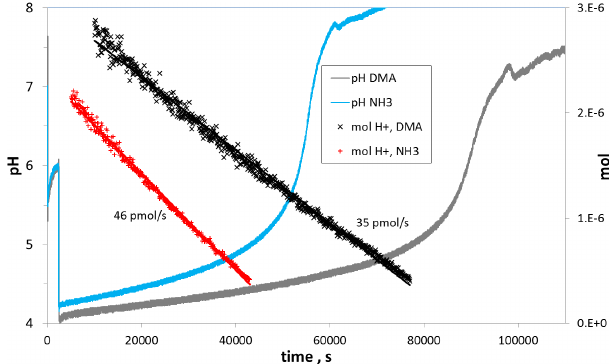
Figure 1. Titration of dimethylamine and ammonia PTs. The gray and light blue lines show the pH of the KCl solutions as they were degassed (0–3000s), upon addition of HCl (3000s), and then intro- duction of the PT effluents at ∼ 4000s. The black and red symbols are the moles of H + neutralized by the dissolving base and linear fits to the data for pH < 5 are also